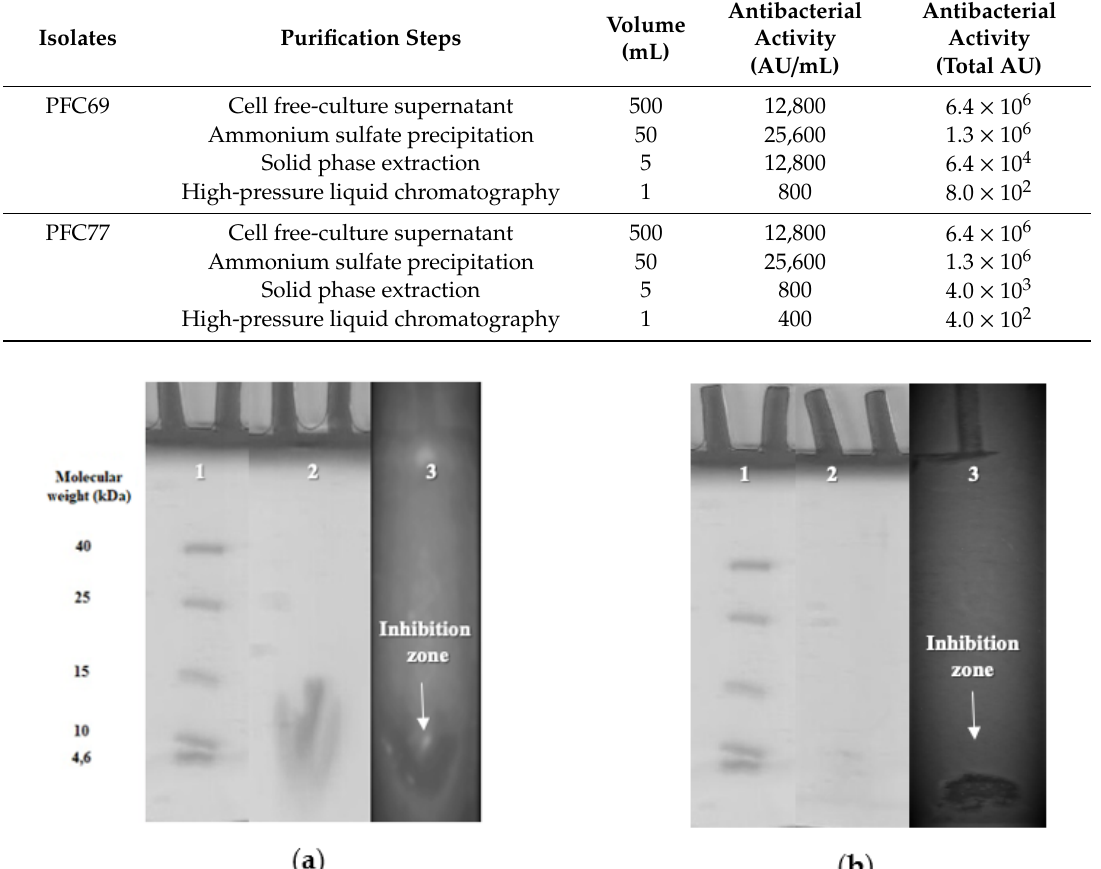
Table 3. Bacteriocin activities produced by P. acidilactici PFC69 and L. lactis PFC77 in the purification steps.